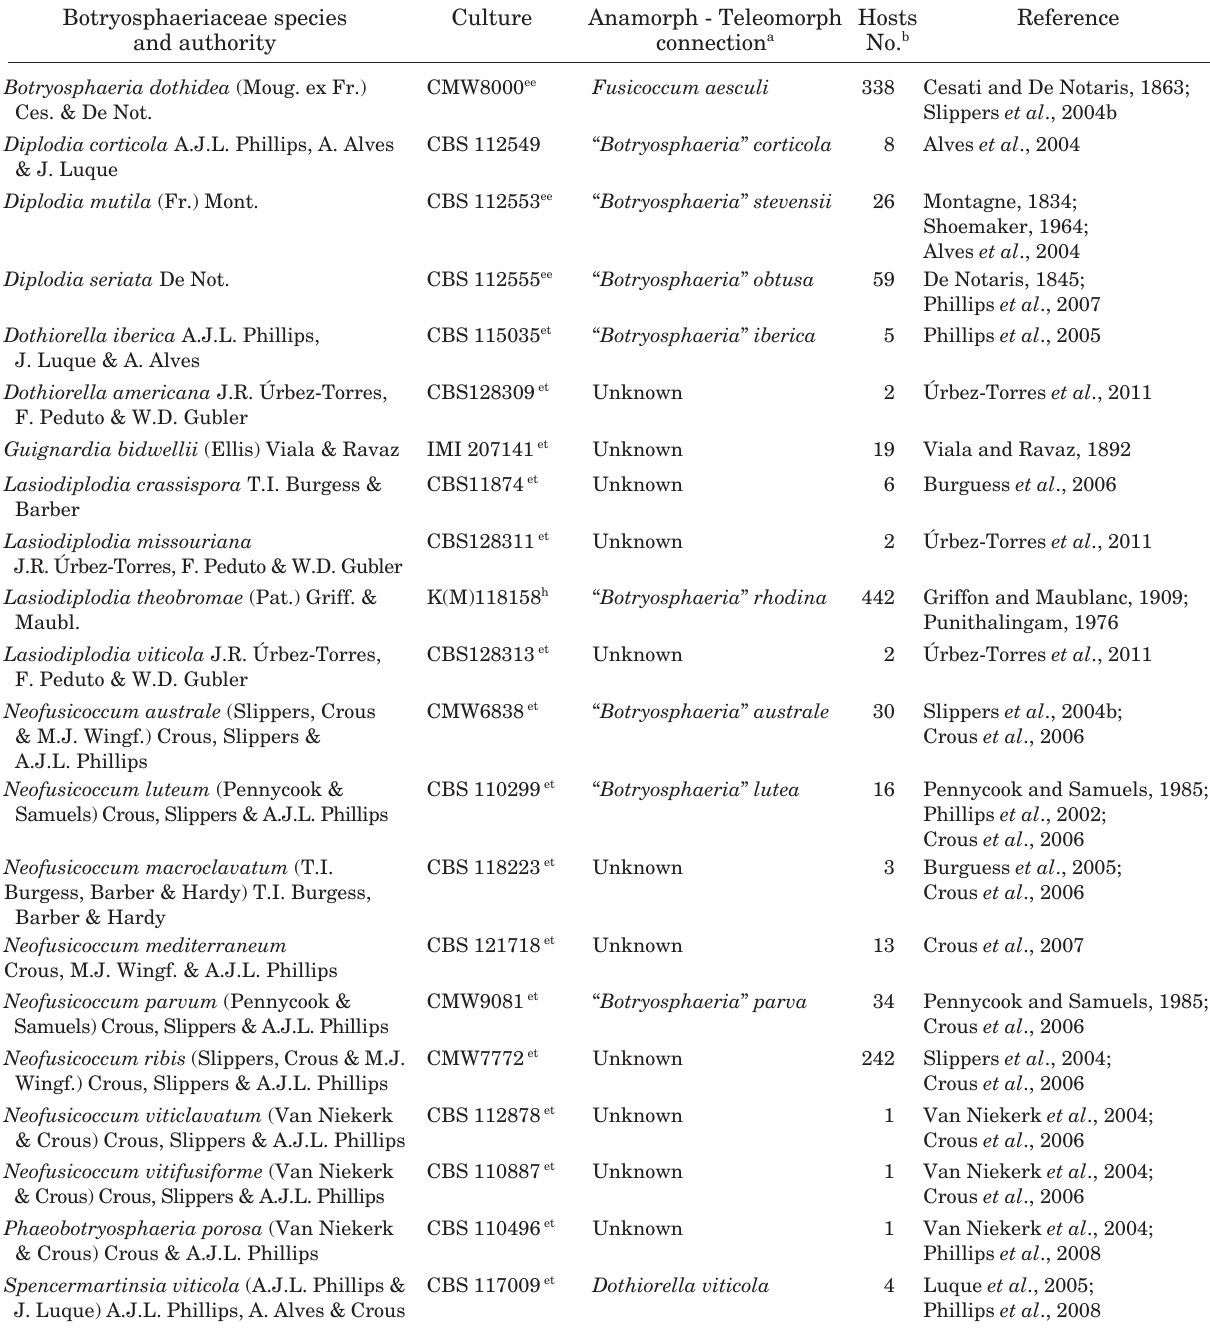
Table 1. Species of Botryosphaeriaceae currently known to infect